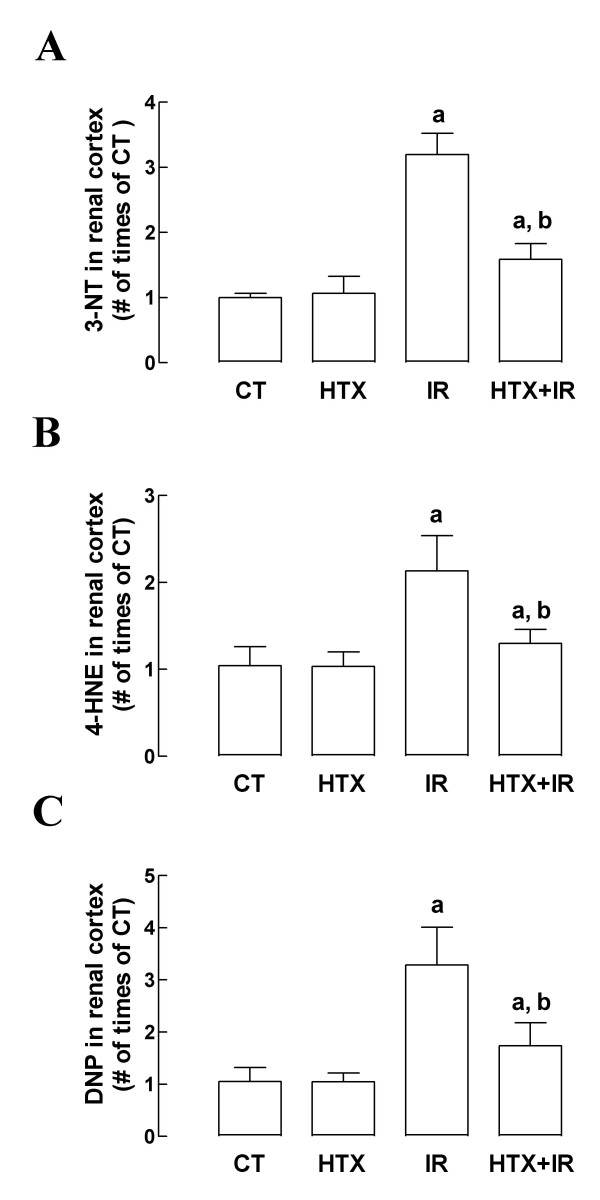
Quantitative immunostaining of 3-NT, 4-HNE, and DNP-modified proteins in renal cortex of the four groups of rats studied: CT, HTX, IR, and HTX+IR. n = 4 rats and 10 determinations/rat. Mean ± SD. aP < 0.001 vs. control, bP < 0.001 vs. IR.